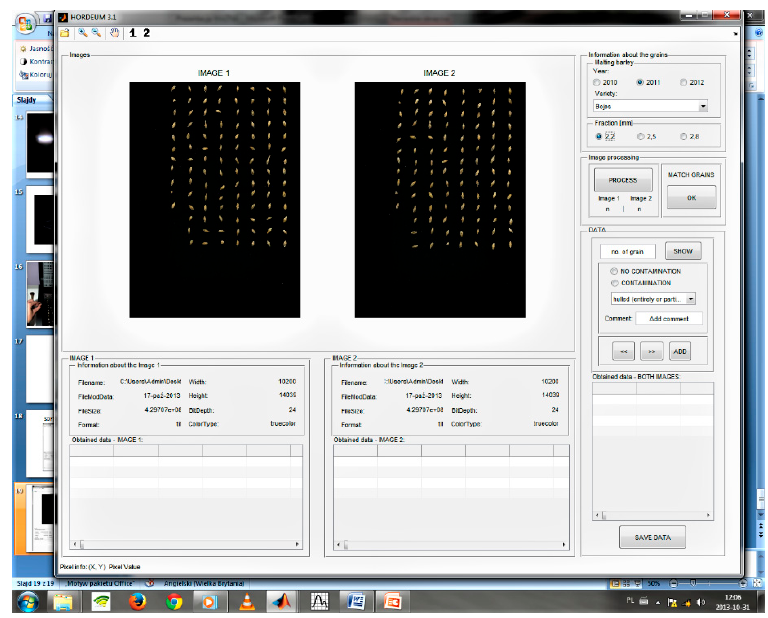
Figure 4. The main window of the new version of “ Hordeum 3.1” software. A schematic procedure for neural identification of selected malting barley varieties is shown in Figure 5.